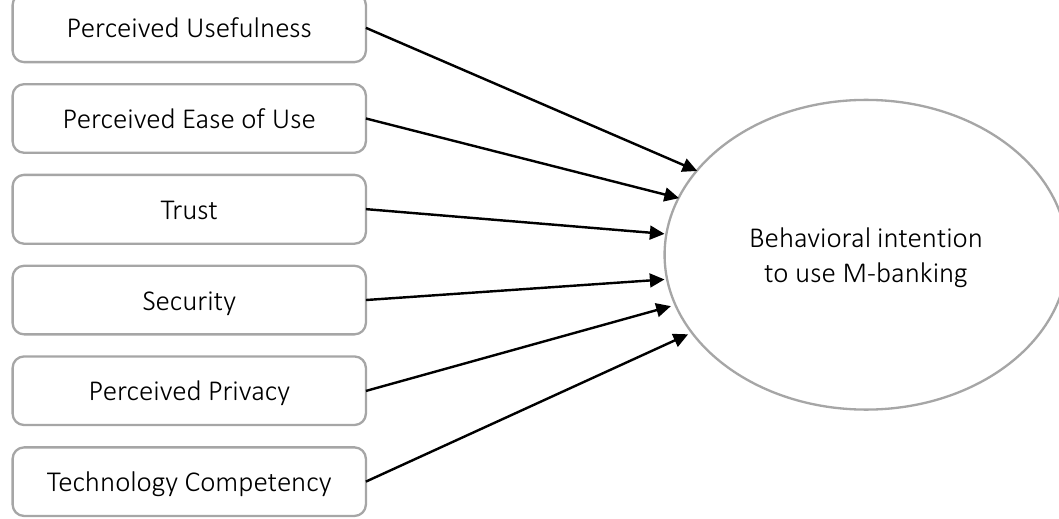
Figure 1. Conceptual framework of the